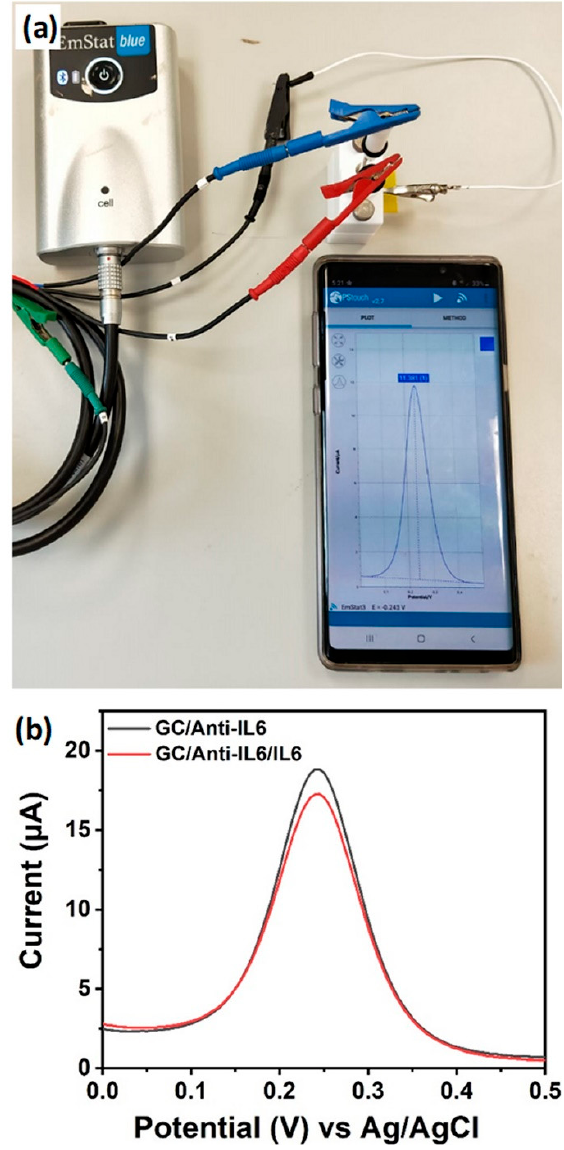
Figure 6. ( a ) Photograph of setup used for detection of IL-6 with handheld instrumentation; ( b ) DPV curves recorded with handheld instrumentation of 10 pg/mL IL-6 conducted in PBS at pH 7.4 containing 5 mM Fe(CN) 6 ] 3 − /4 − .